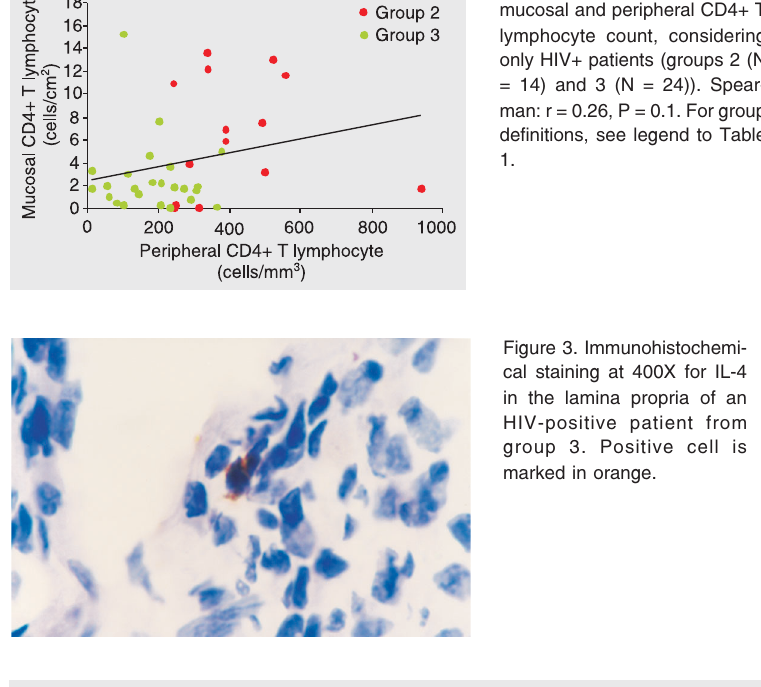
Table 5. Characteristics of cytokines and IL-2 receptors in the duodenal mucosa.